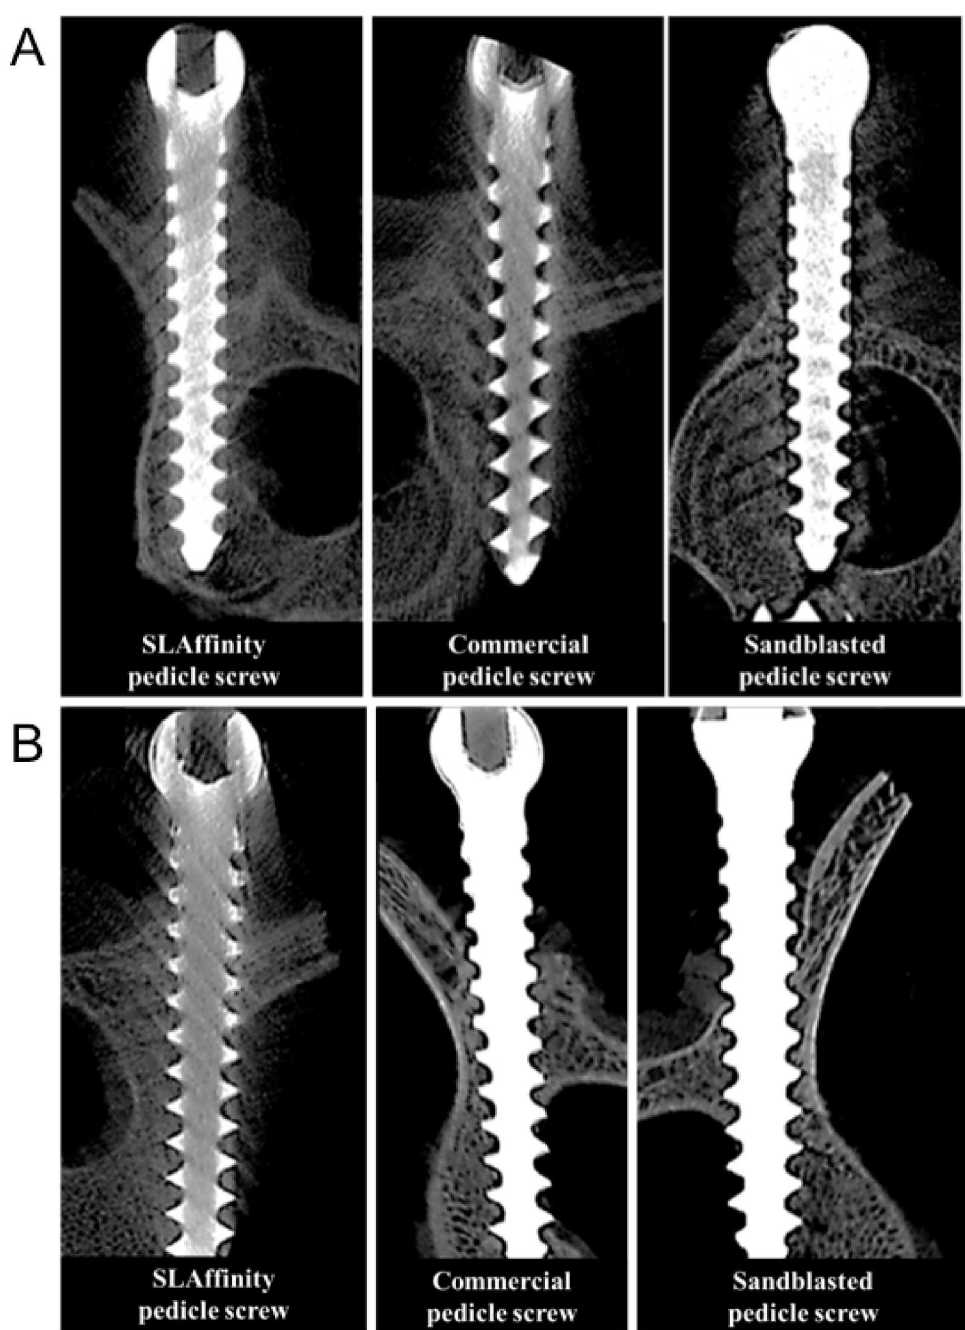
Fig 4. Micro-CT images of different pedicle screws inserted into vertebral column after implantation. (A) 1 month and (B) 3 months after